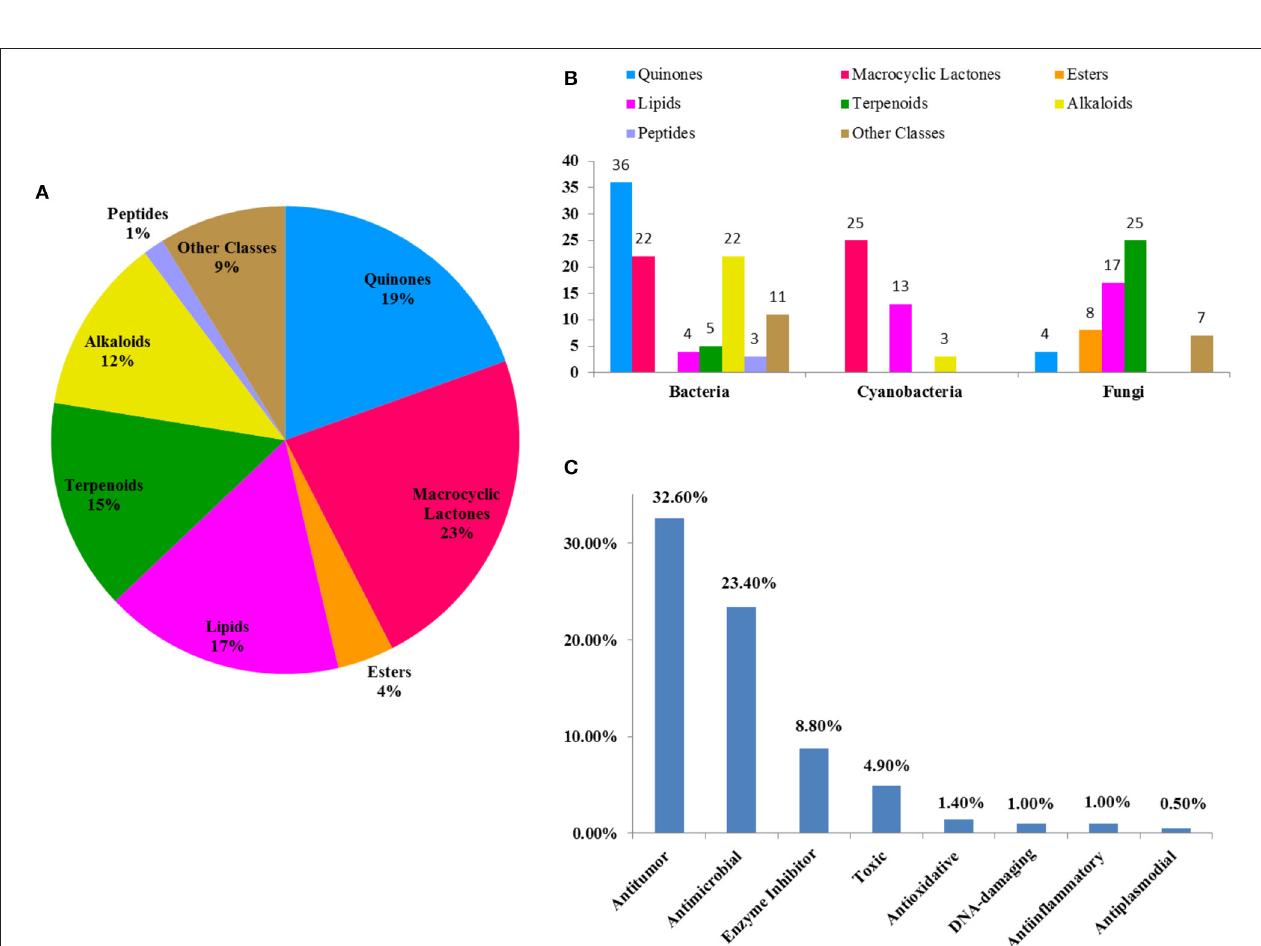
FIGURE 15 | The percent of each class glycosides out of all glycosides (A) ; the distribution of each class glycosides in marine microbes (B) ; the percent of each class bioactive glycosides out of all glycosides (C) .